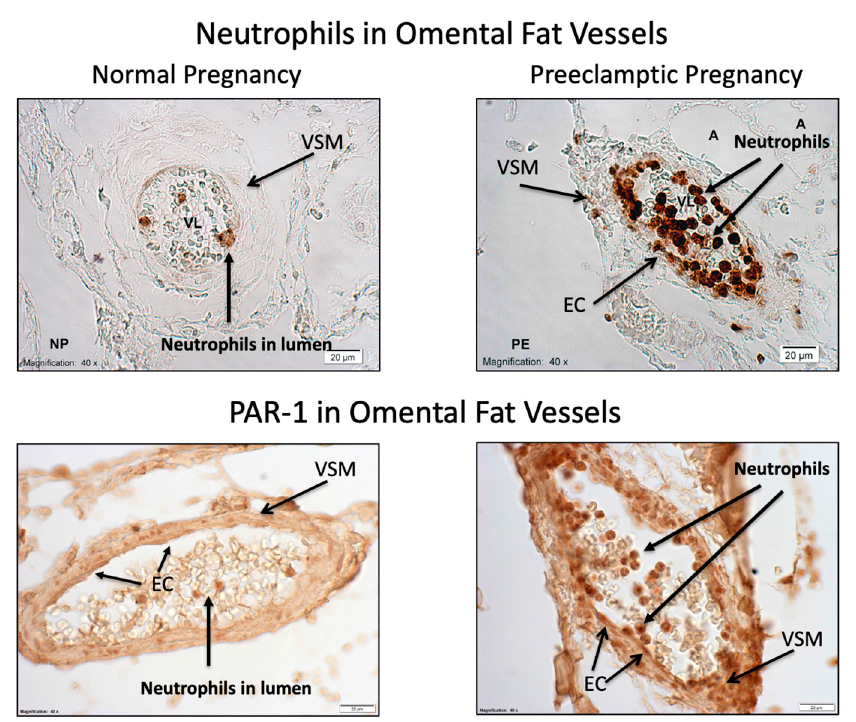
Figure A1. Comparison of the extensive infiltration of neutrophils and the increased expression of PAR-1 in maternal omental fat vessels in preeclampsia as compared to normal pregnancy. (EC, endothelial cells; VSM, vascular smooth muscle; VL, vessel lumen; A, adipose cell) (Modified from Ref. [1], Walsh, Strauss, Int J Mol Sci, 2021;22:6985 and Ref. [3], Walsh, Strauss, Am J Obstet Gynecol, 2022;226:S945-s53).